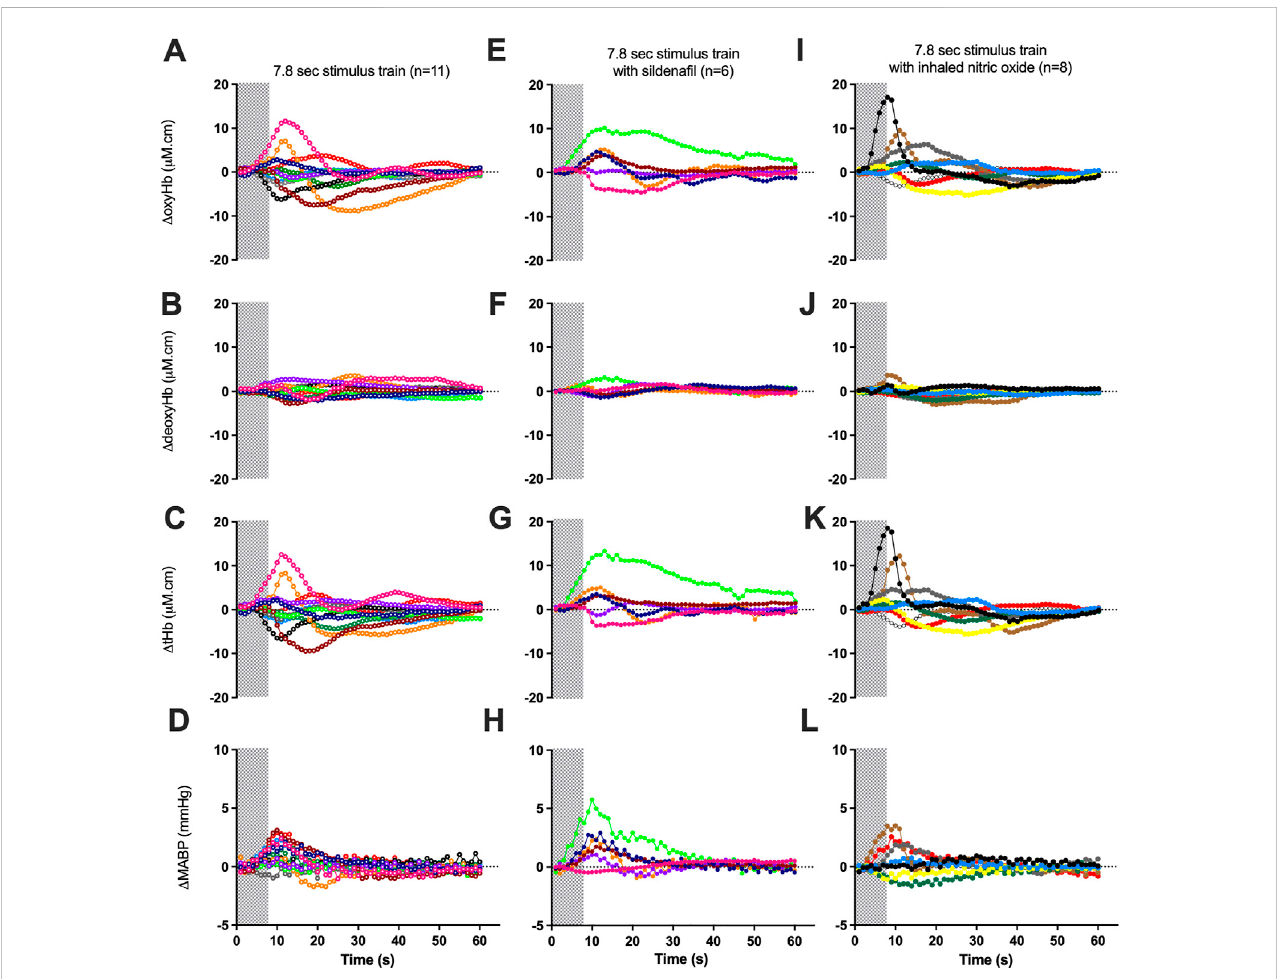
FIGURE 3 Changes in oxy-, deoxy- and total haemoglobin [ Δ oxyHb; (A, E, I) , Δ deoxyHb; (B, F, J) , and Δ total Hb; (C, G, K) ], recorded from the contralateral hemispheres, and mean arterial blood pressure [ Δ MABP; (D, H, L) ], following a 3.3 Hz stimulus train of 7.8 s in control lambs [open circles; (A – D) ], lambs with sildena fi l infusion solid circles; (E − H) ] or with inhaled nitric oxide [solid circles; (I-L) ]. Individual lambs are indicated by different colours. Shaded area in each graph indicates the period of